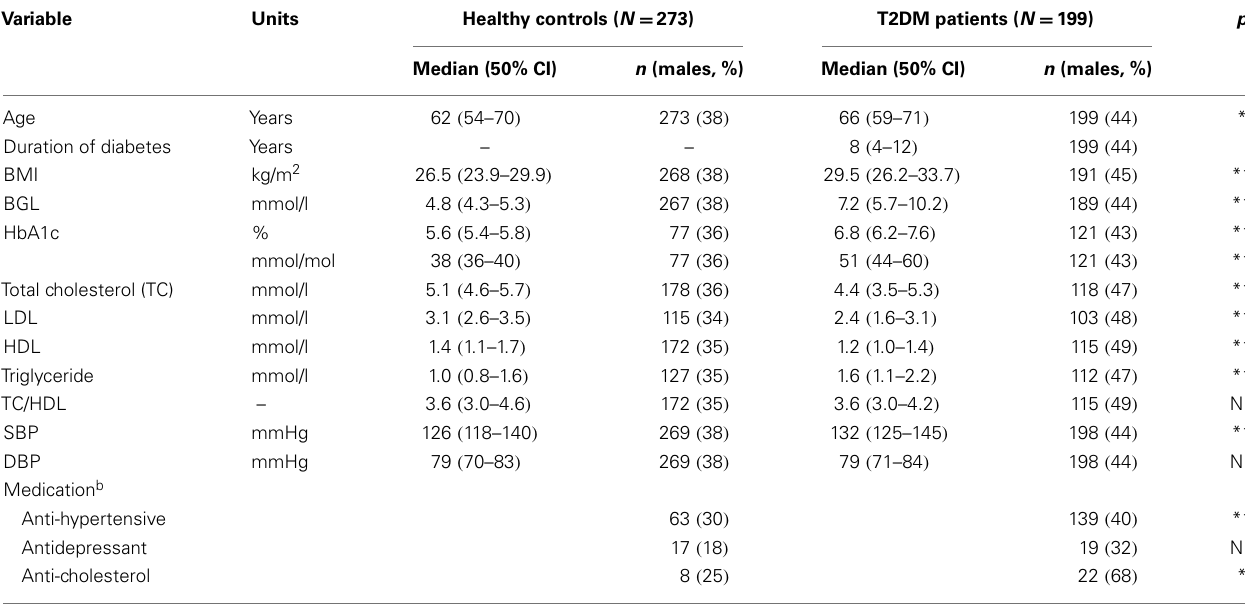
Table 1 | Clinical characteristics of the healthy control subjects andT2DM patients participating the study